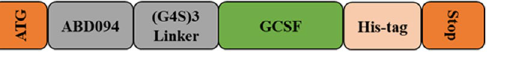
Figure 1. Schematic view of the expression